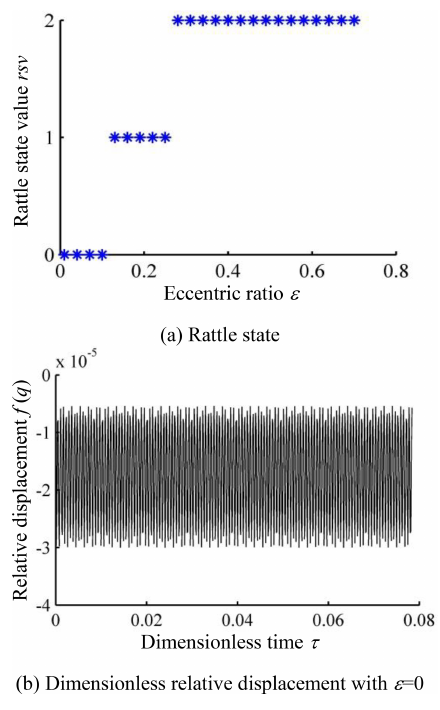
Figure 13. Change in vibration with eccentric